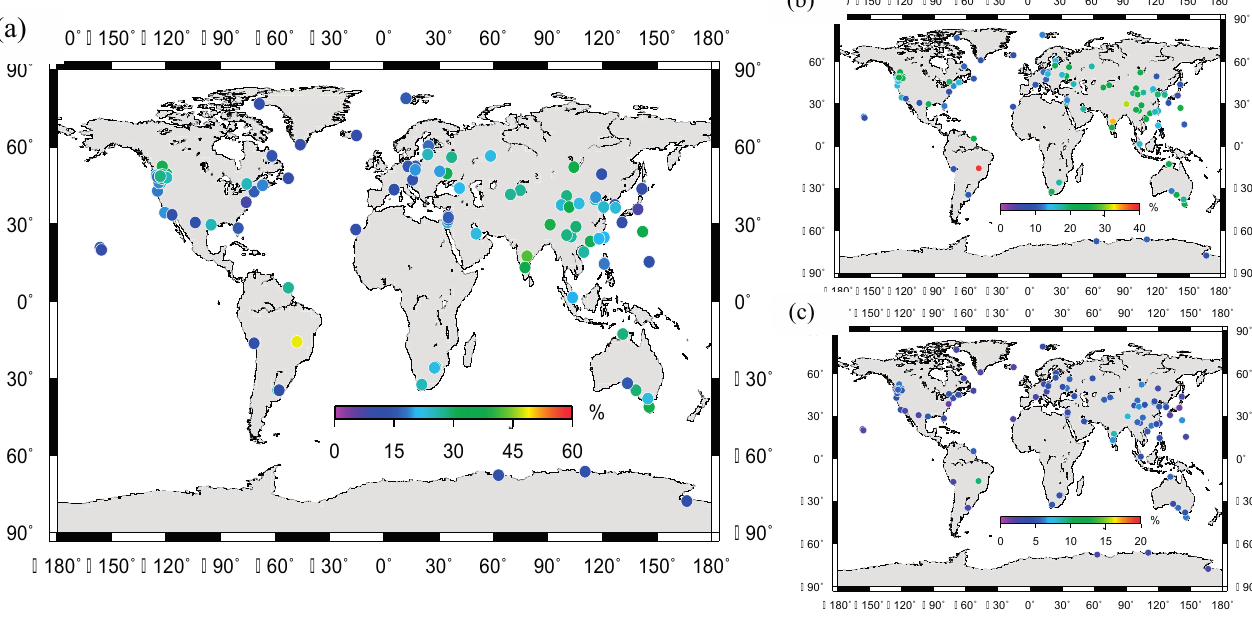
Figure 9. WRMS reduction rates for GPS de-trended vertical time series after removing seasonal and quasi-biennial signals de-trended displacements. The color bar denotes percentage of WRMS reduction rate after signals removed from GPS time